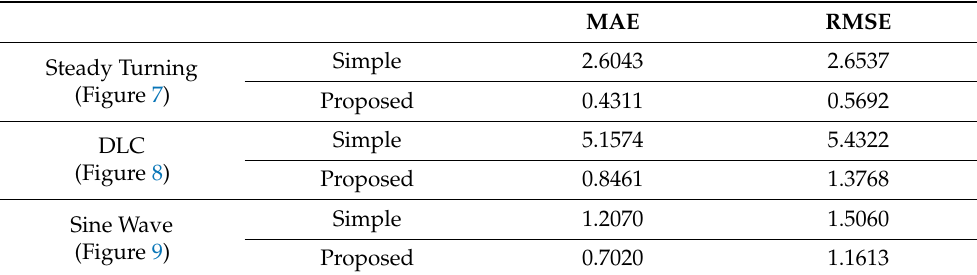
Table 1. Error statistics for roll angle